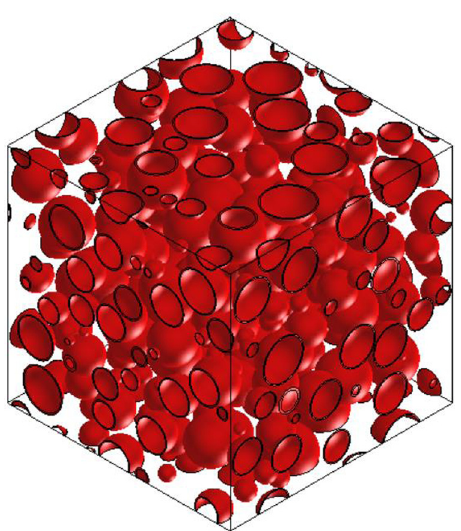
Figure 12: Random CNT orientation represented by di ff erent colors in a unit cell.